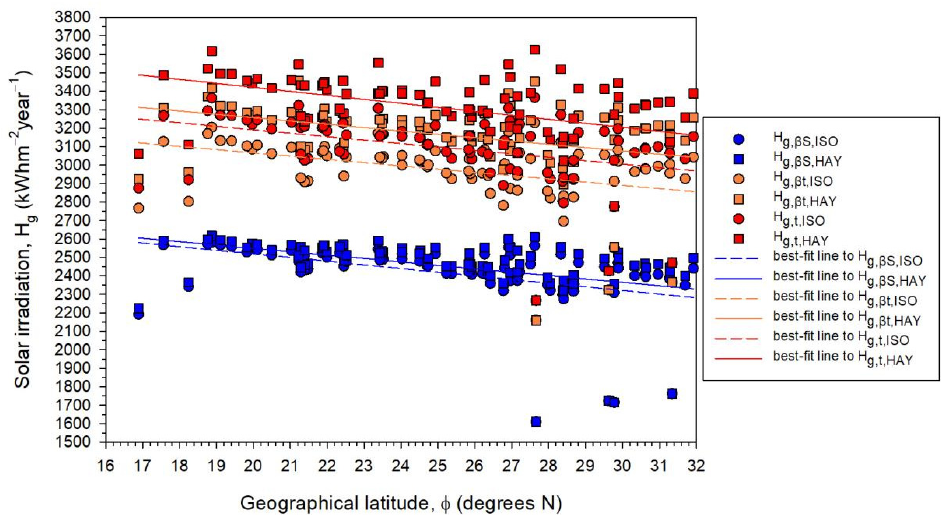
Figure 6. Annual solar energy yields, H g , at the 82 sites in Saudi Arabia averaged over the period 2005–2016 as a function of the geographical latitude of the site, φ , under all-sky conditions. The data are shown for the 3 solar system configuration modes and both ISO- and HAY-modelled results. The best-fit lines have the following expressions: configuration mode-(i), H g, β S,ISO = 2914.9263 − 19.8053 φ with R 2 = 0.18, H g, β S,HAY = 2916.8787 − 18.3831 φ with R 2 = 0.14; configuration mode-(ii), H g, β t,ISO = 3418.2774 − 17.5874 φ with R 2 = 0.14, H g, β t,HAY = 3617.0141 − 17.9937 φ with R 2 = 0.10; configuration mode-(iii), H g,t,ISO = 3563.8445 − 18.6120 φ with R 2 = 0.15, H g,t,HAY = 3854.0829 − 21.6483 φ with R 2 = 0.13.